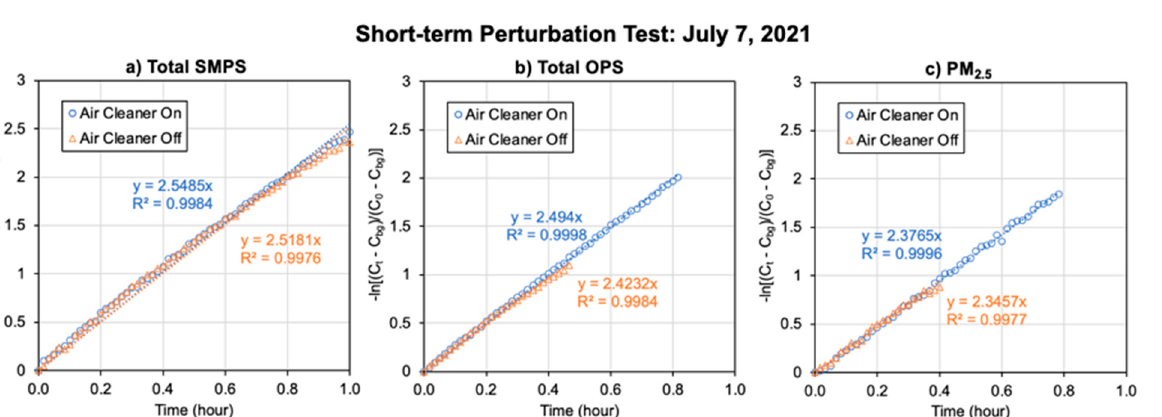
Figure 10. First-order particle loss rate constants ( λ + k ) from a long-term perturbation test (12 July 2021) after the air cleaner operated for 24+ hours and after the air cleaner was switched off: ( a ) total number concentrations measured by the SMPS (0.01–0.4 µm), ( b ) total number concentrations meas- ured by the OPS (0.3–10 µm), and ( c ) estimated PM 2.5 mass concentrations.